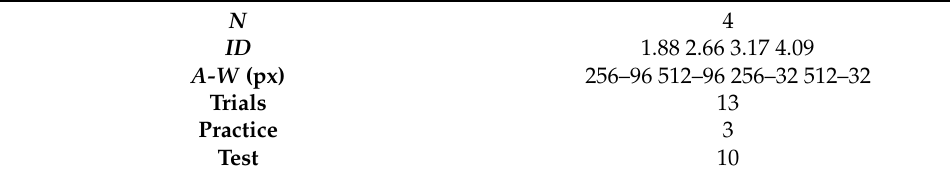
Table 1. Summary of the test parameters (N: number of conditions, ID : index of difficulty, A-W : amplitude-width in